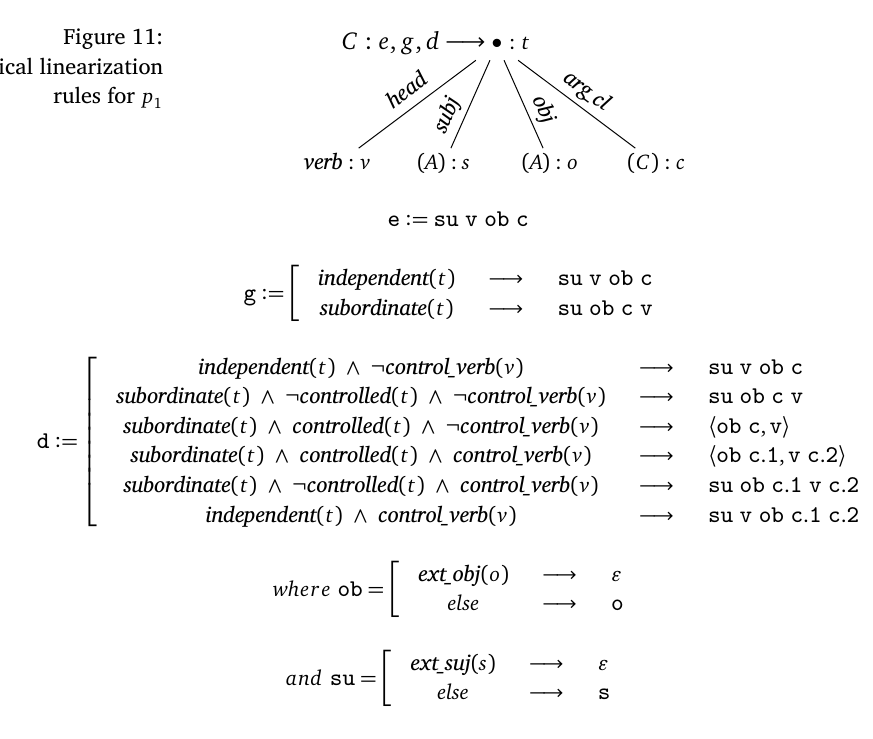
Figure 11: Phonological linearization rules for p